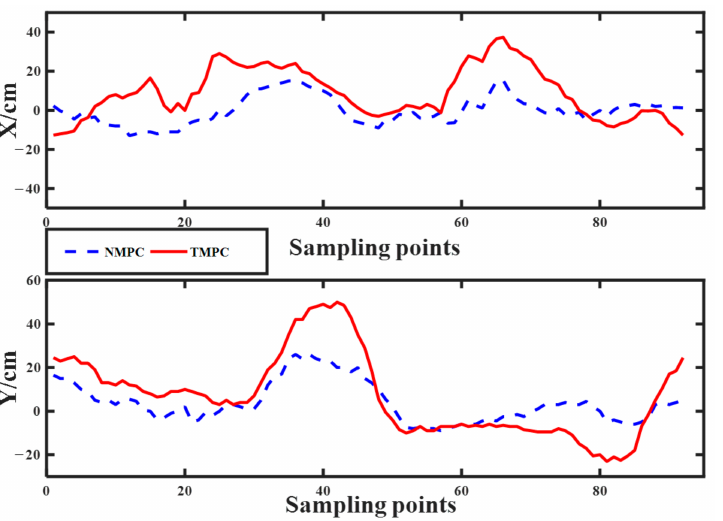
Figure 15. The tracking errors of x and y for the two MPC controllers under the